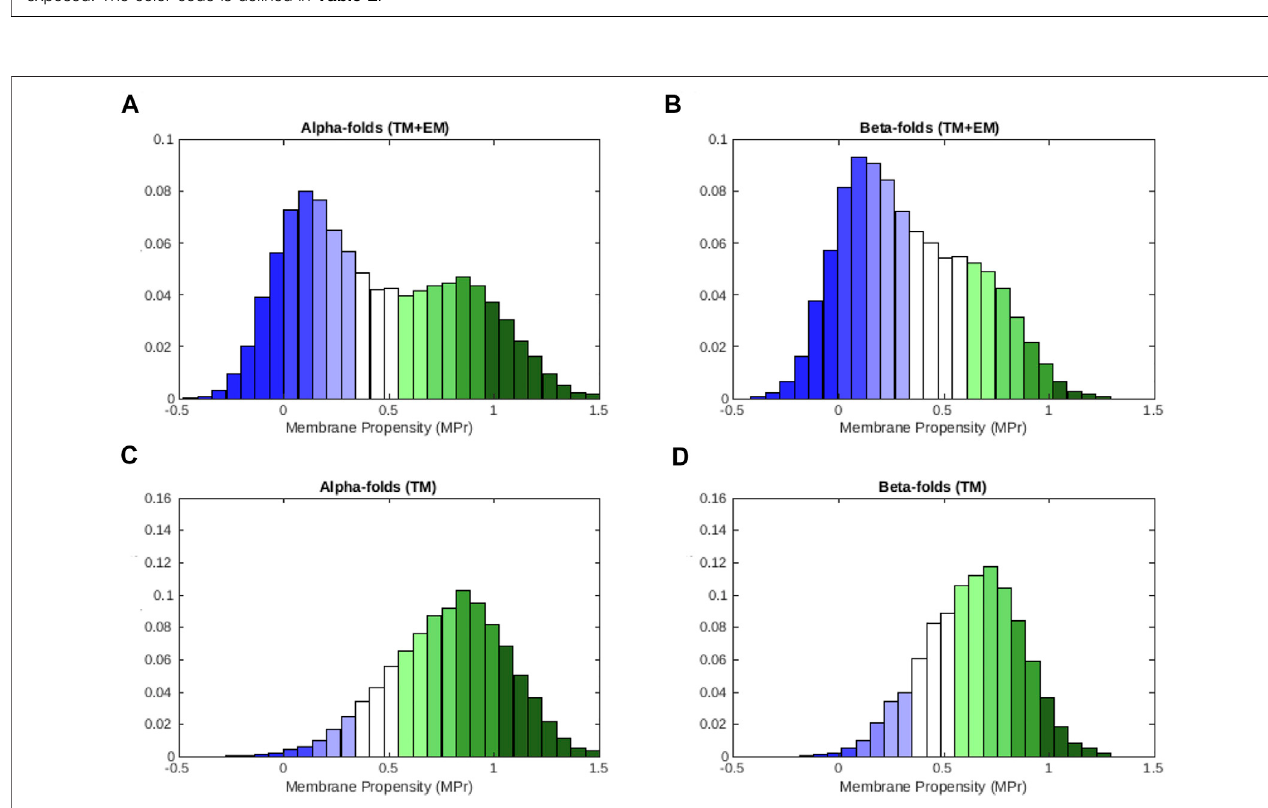
FIGURE 3 | MPr distribution computed from the membrane proteins in D mem that have an α -helical or β -barrel structure. (A) α -folds (TM and EM), (B) β -folds (TM and EM), (C) TM region of α -folds and (D) TM region of β -folds. The color code is de fi ned in Table 2 .